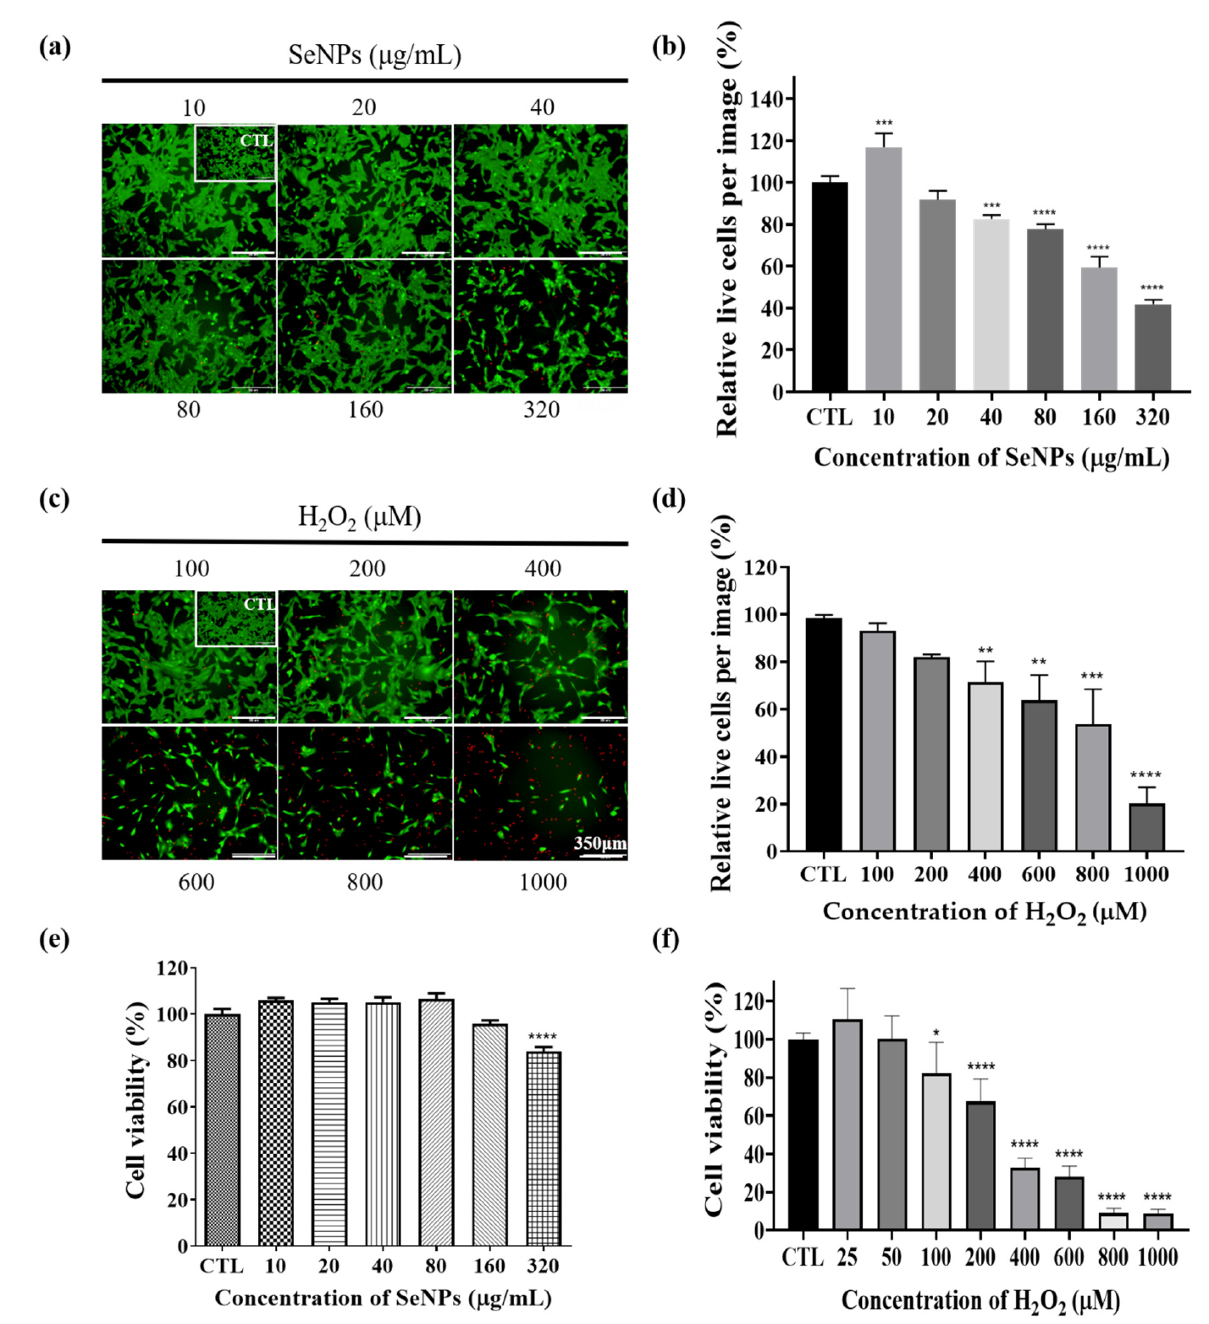
Figure 2. Cell viability was determined by live (green) and dead (red)-staining, and CCK-8 assays. After cell seeding for 24 h, C2C12 cells were analyzed using CCK-8 solution and stained using live/dead solution to evaluate viability. ( a ) Live/dead- staining following treatment with various SeNPs concentrations. ( b ) The quantitative live/dead assay results, which were treated with SeNPs. ( c ) Live/dead-staining following treatment with various H 2 O 2 concentrations. ( d ) The quantitative live/dead assay results, which were treated with H 2 O 2 . ( e ) The relative cell viability of C2C12 cells cultured in different SeNPs concentrations. ( f ) Viability of C2C12 cells treated with various concentrations of H 2 O 2 . All data was normalized by control cell numbers. The statistical significance of ( e , f ) was calculated using one-way analysis of variance (ANOVA), followed by a two-sided Dunnett’s multiple comparison test compared to the control (CTL; scale bar = 350 µm). * Represents p < 0.05, ** p < 0.01, *** p < 0.001, and **** p < 0.0001; n = 3., * compared with the SeNPs and H 2 O 2 -untreated groups.